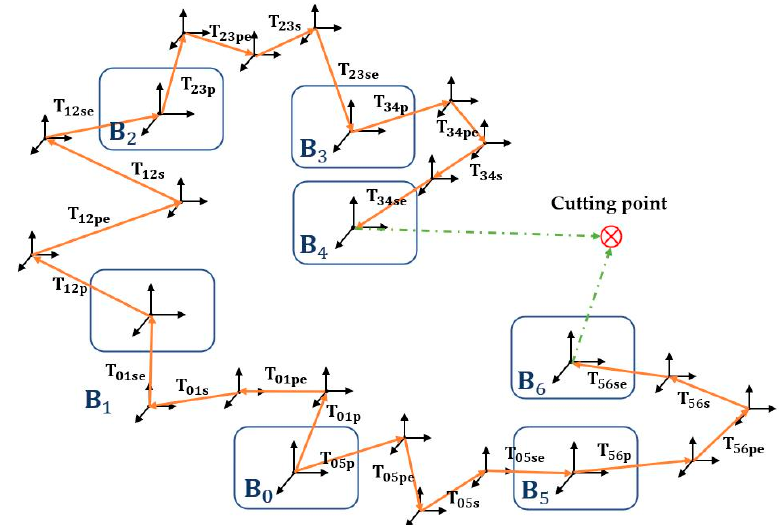
Figure 2. The topology structure and coordinate definition of the machine. Orange lines show the coordinate transformation between different bodies, which are marked with T01p, T01pe, etc.